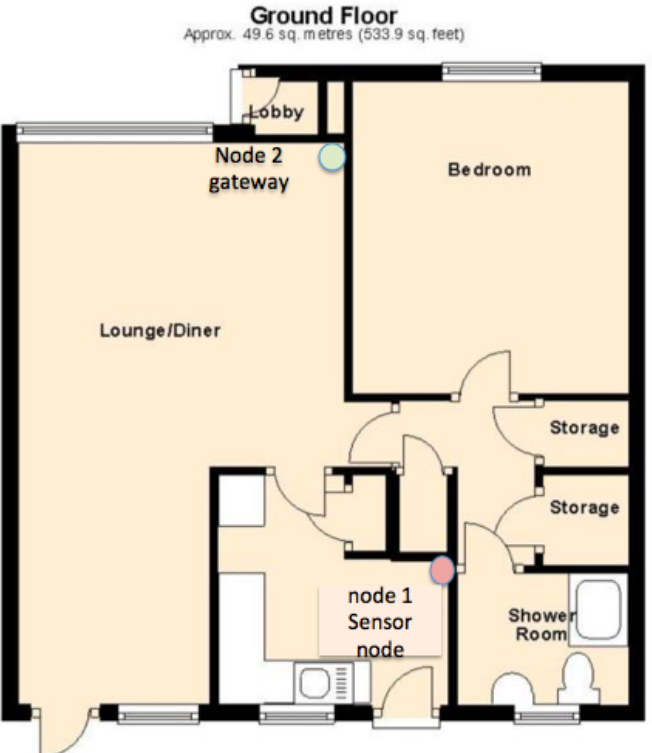
Figure 3. Floor plan of the experiment setup with two nodes in a domestic environment. One node (acting as a gateway node with an attached speaker) was placed in the living room and another node (a sensor node with an attached microphone) was placed in the kitchen area (Figure 4). The data that were collected informed the size of the different networks, as the optimal number of nodes for different locations varied due to the loca- tion/room size and its ambient noise level. The gateway node received the transmissions from the sensor nodes and unpacked the data. A Python-based NN library was installed on the gateway node, which was used to test the data and generate predictions.